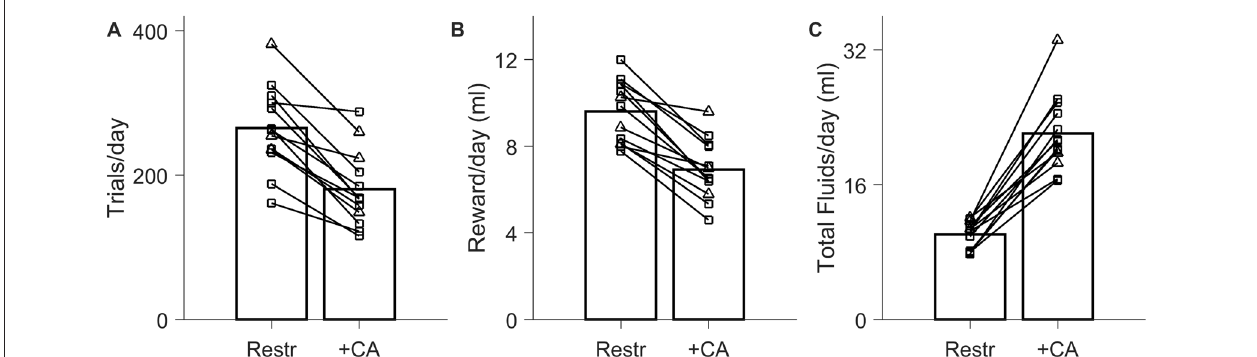
FIGURE 3 | Effect of ad lib CA water on trial rates in 2-h daily sessions. Data from N = 13 experiments on N = 7 rats. In all panels, circles indicate comparisons in which no supplemental water was given in either condition ( N = 10); triangles indicate cases in which supplemental water was required and provided in the restricted condition ( N = 3). (A) Number of trials performed per day in 2-h daily testing sessions, when rats were water restricted the other 22 h (Restr) vs. when rats had ad lib 2% CA the other 22 h (+CA). (B) Quantity of water earned in the form of task rewards, with and without ad lib 2% CA between sessions. (C) Total fluid intake per day (sum of earned water rewards, ad lib 2% CA consumption, and supplemental water if